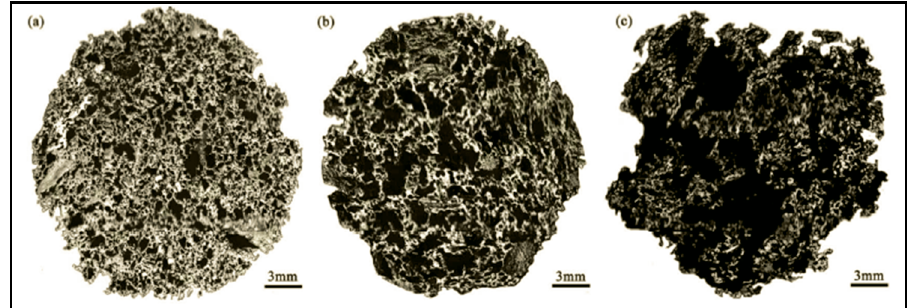
Figure 5. Panoramic images of coke under different reaction conditions, adopted from [64], with permission of American Chemical Society, 2017. ( a ) Unreacted coke; ( b ) Coke reacted with pure CO 2 ; ( c ) Coke reacted with pure H 2 O.